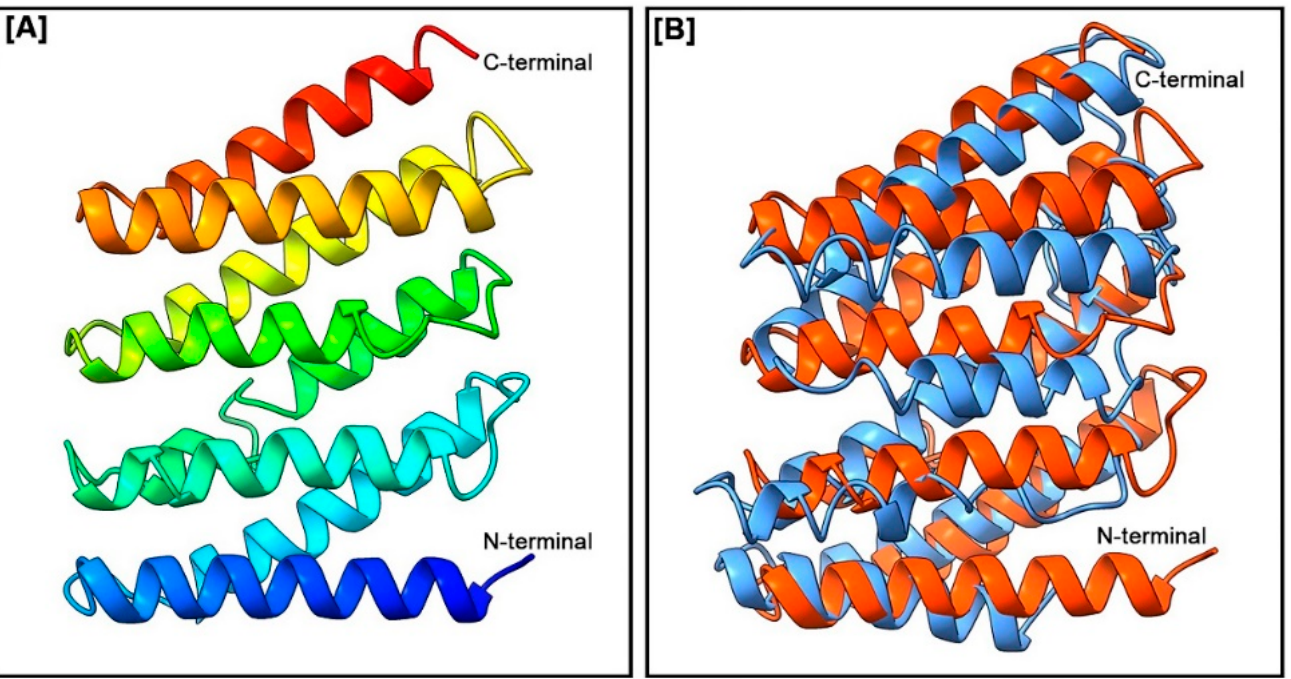
Figure 4. ( A ) Three-dimensional amino acid sequence model of Hdh-FMRF2. The model was constructed using the I-TASSER online tools. Domains between the N-terminal and C-terminal were predicted from the secondary structure. ( B ) Three-dimensional structure alignment of the H. discus hannai FMRF2 (in orange) and the H. asinine FMRF2 (in sky blue).